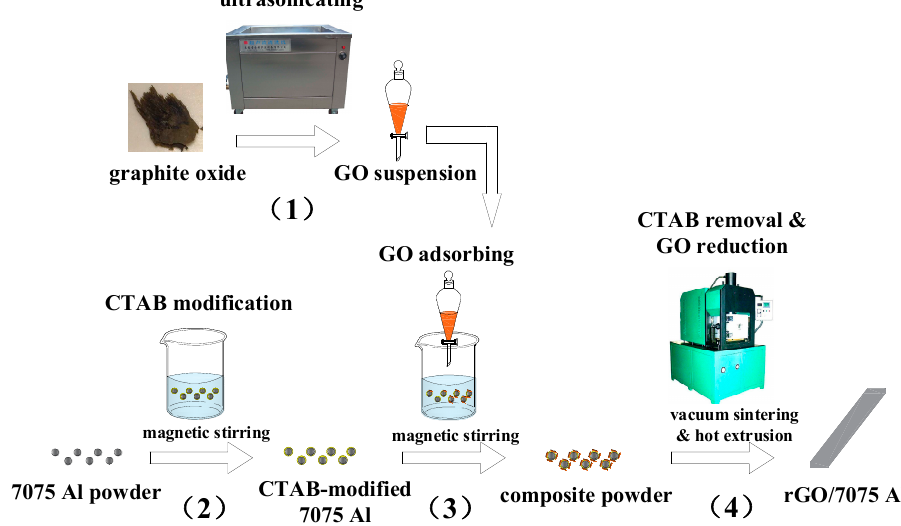
Figure 1. Fabrication procedures for rGO/7075 Al composites.